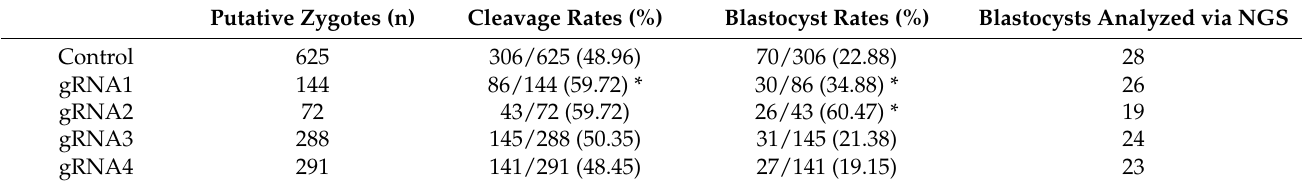
Table 1. Embryo development after zygote CRISPR/Cas9 injection (gRNA 1, 2, 3, and 4). Zygotes included in the control group were non-injected.